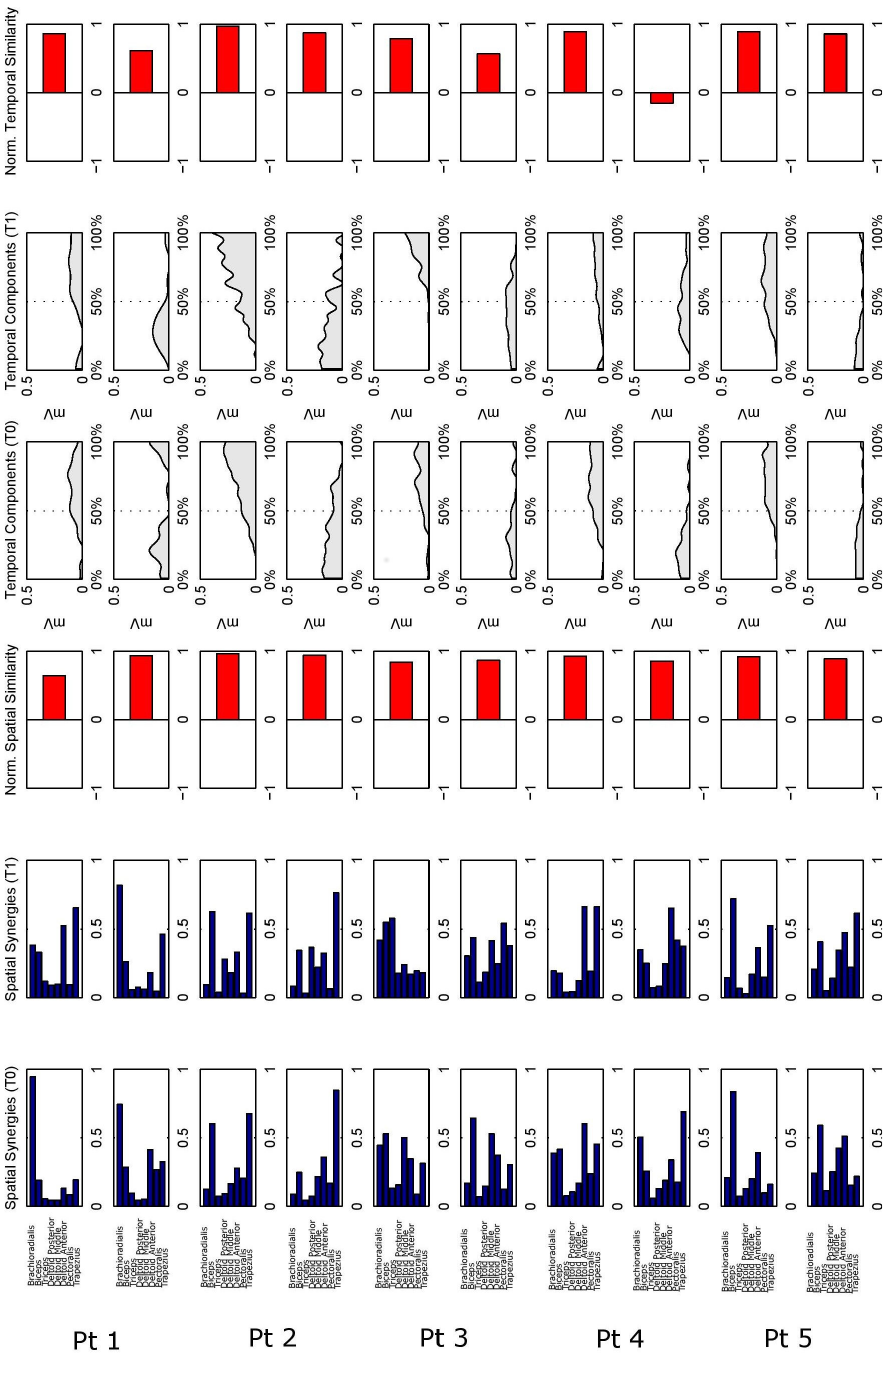
Figure 4. Patients’ spatial synergies, extracted at T0 and T1, are depicted in the first and second columns, respectively. The corresponding temporal components are depicted in the fourth and fifth row. For each T0/T1 correspondent couple of motor modules, similarity on spatial synergies and on temporal components is reported in column 3 and column 6,